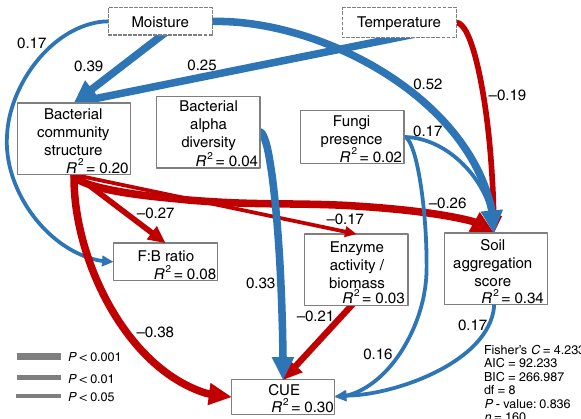
Fig. 4 Structural equation model showing the relative in fl uence of soil abiotic and biotic factors on CUE. Signi fi cant paths are shown in blue if positive or in red if negative. Path width corresponds to degree of signi fi cance as shown in the lower left. The amount of variance explained by the model ( R 2 ) is shown for each response variable, and measures of overall model fi t are shown in the lower right. Bacterial community structure: axis 1 of NMDS; Bacterial alpha diversity: bacterial phylogenetic diversity index; Fungi presence: presence/absence of fungi; F:B ratio: 16S rRNA gene copy number g − 1 soil: ITS gene copy number g − 1 soil; Enzyme activity/Biomass: maximum activity recorded for Betaglucosidase/microbial biomass carbon. CUE: carbon use ef fi ciency; Global goodness-of- fi t: Fisher's C. Exact P values for each path coef fi cient are reported in Supplementary Table